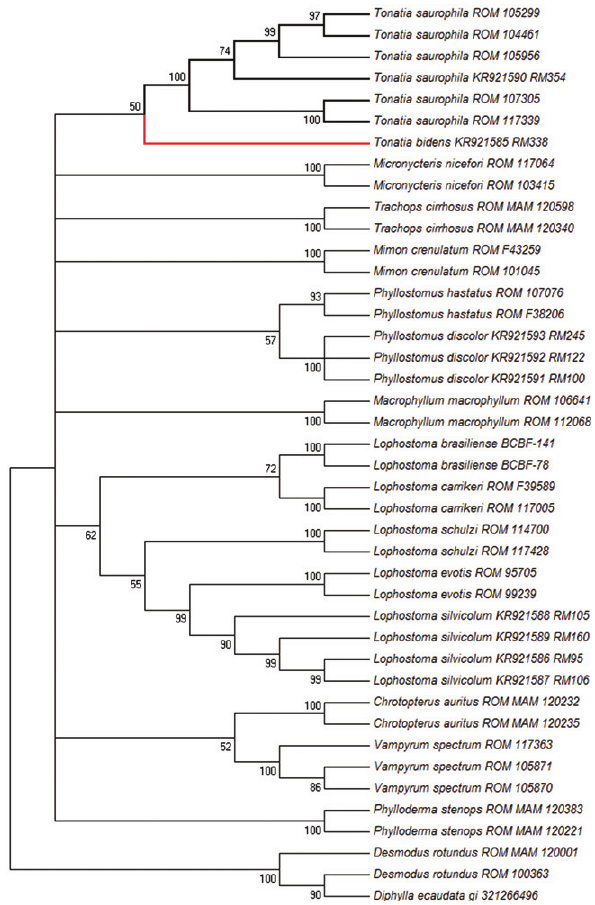
Figure 12. Maximum likelihood (ML) dendogram describing rela- tionships among genera of bats in Phyllostominae and calculated from COI sequence data (the species of Tonatia are highlighted).